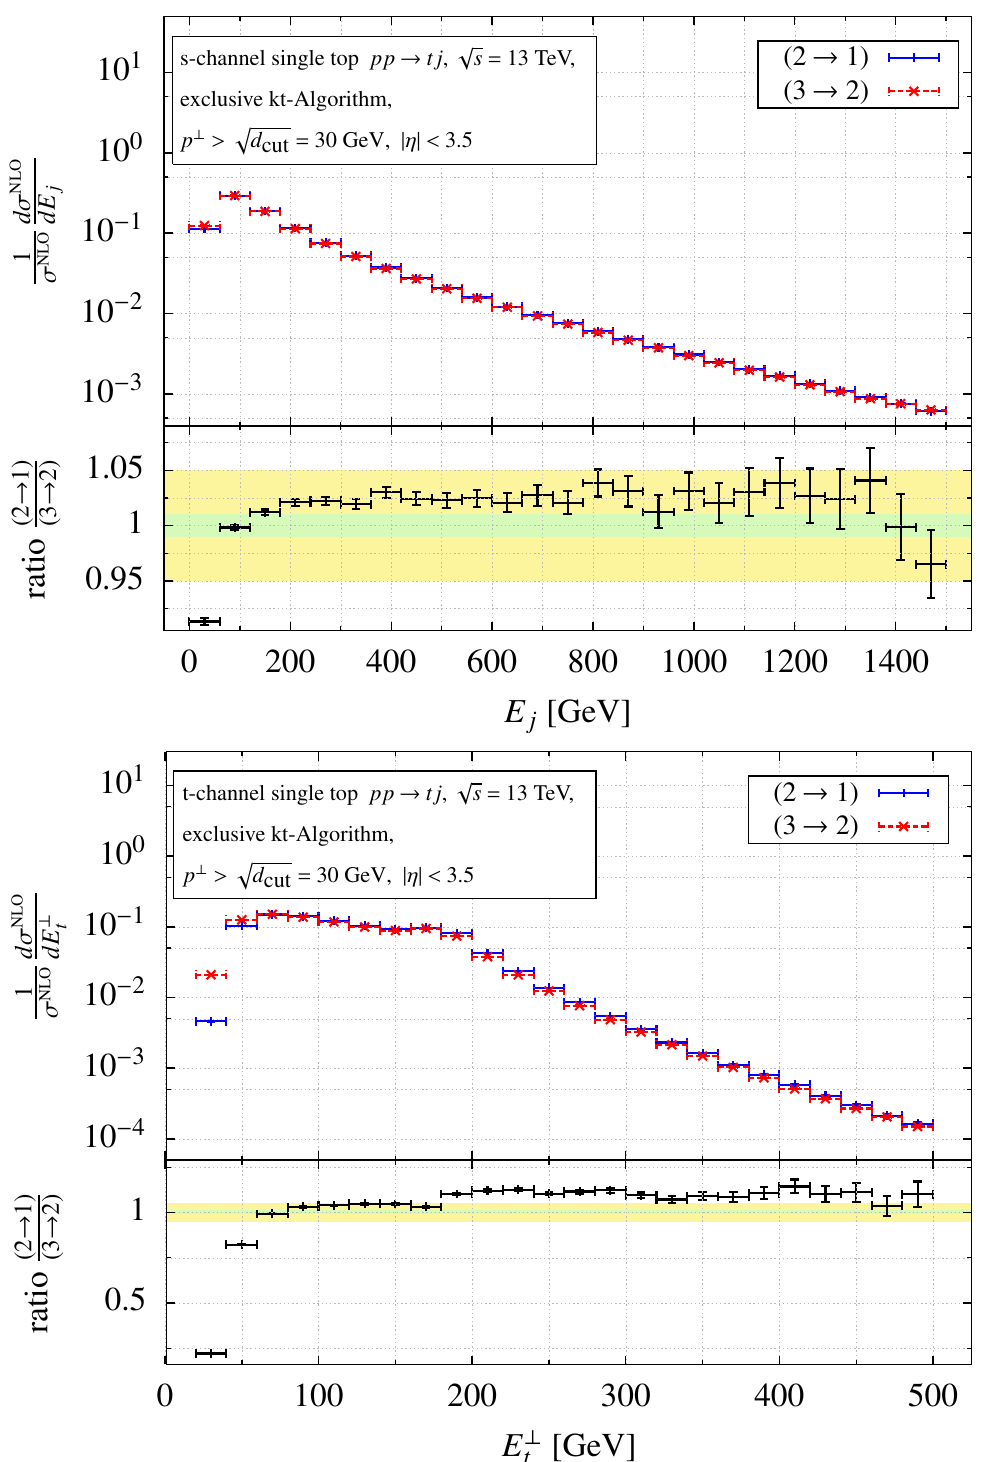
Figure 4 . Examples for (transverse) energy distributions for the top-tagged and the light jet from s - and t -channel single top-quark production at NLO with 3 ! 2 (red, dashed) and 2 ! 1 (blue, solid) jet clusterings.